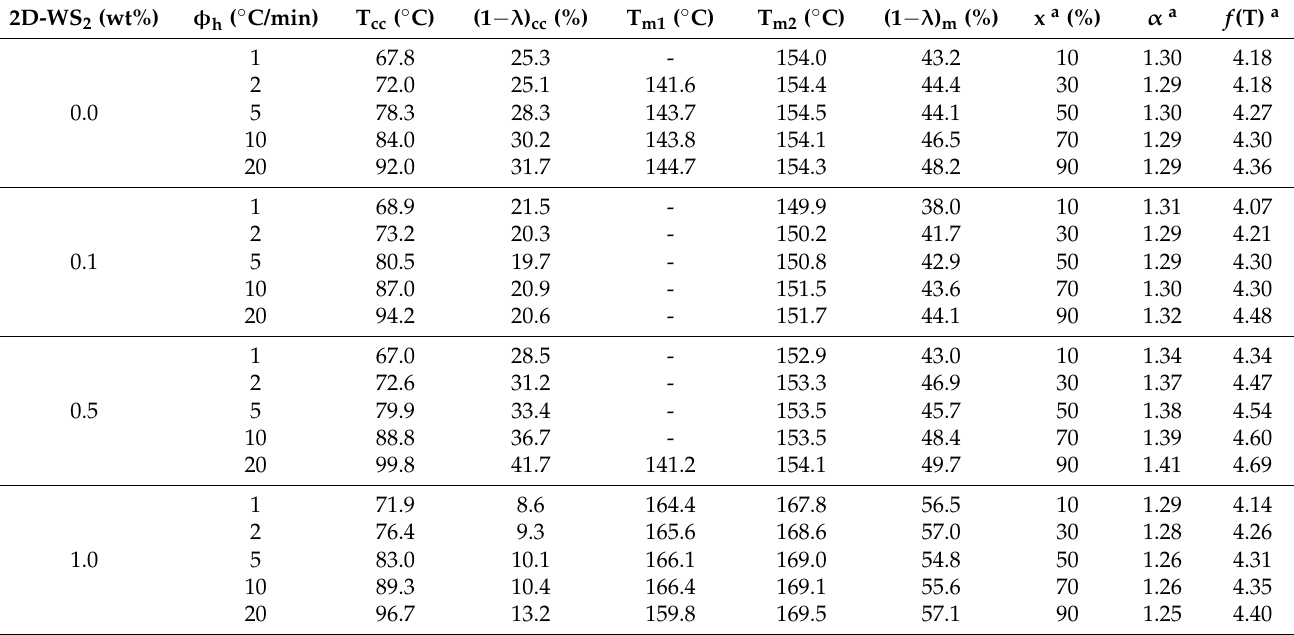
Table 1. Cold-crystallization and melting parameters of the neat PLLA and PLLA/2D-WS 2 nanocomposites. 2D-WS 2